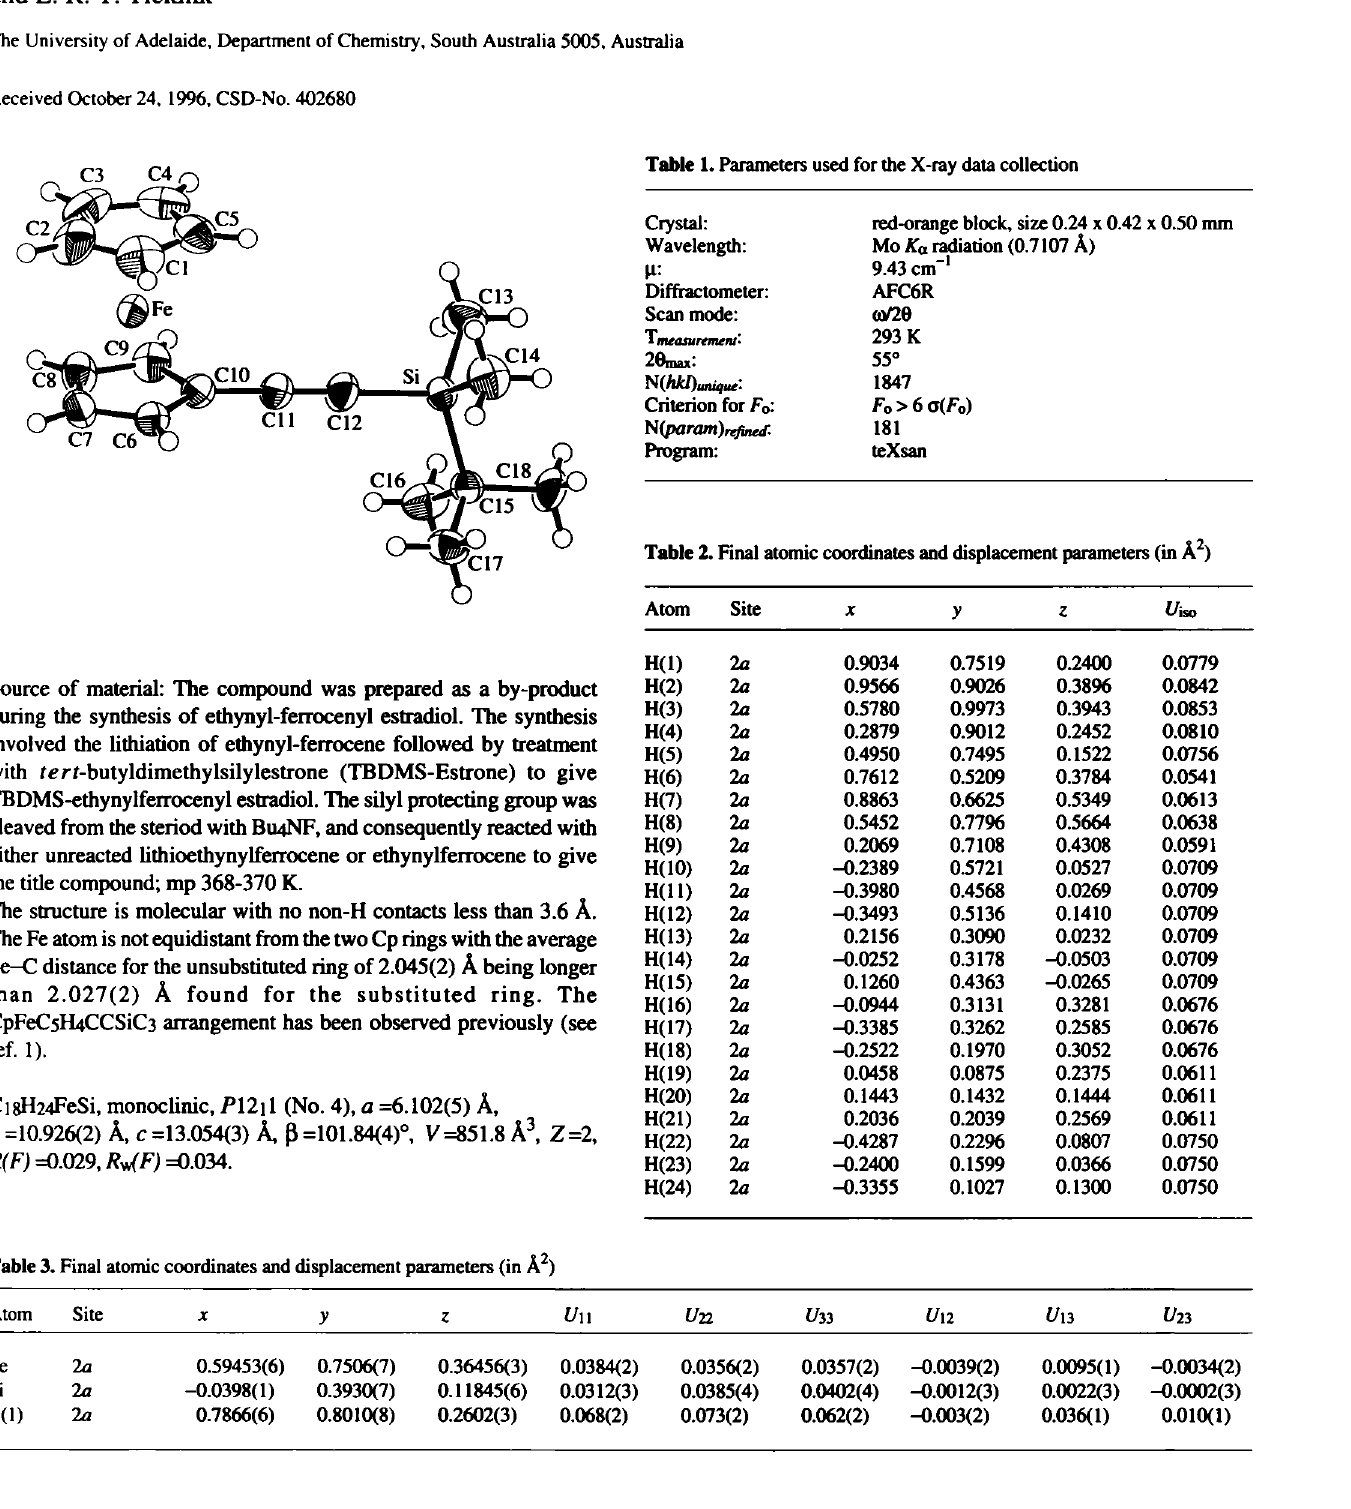
Table 3. Final atomic coordinates and displacement parameters (in Â 2